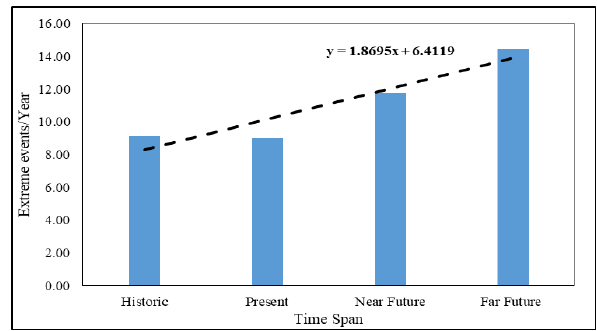
Figure 27 Extreme Flood Peaks Trend over time